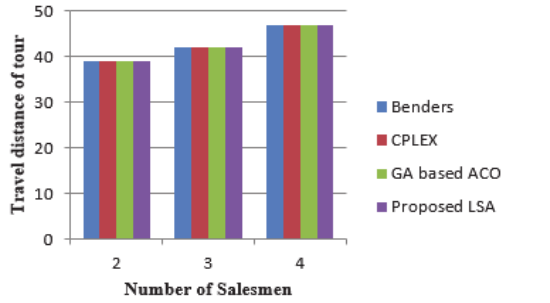
Fig. 5. Comparison of travel distance for ftv33 by considering two, three and four